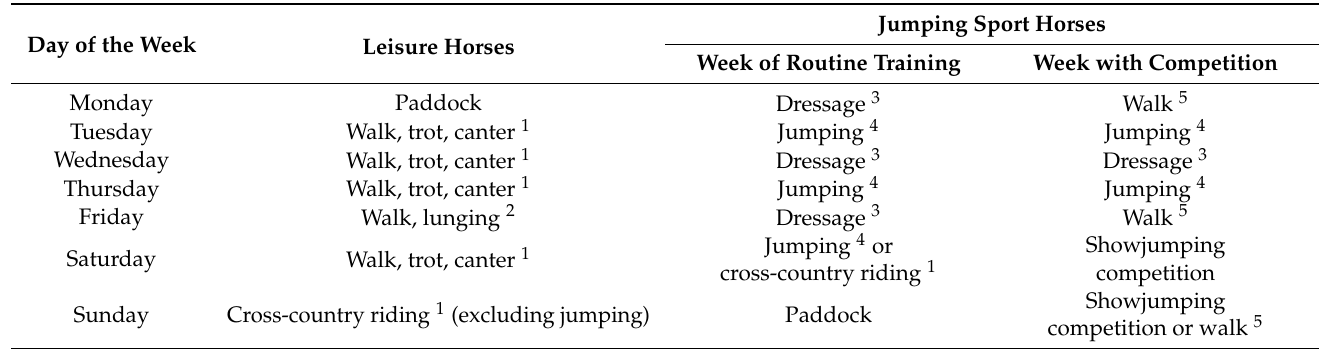
Table 1. Weekly cycle of horses’